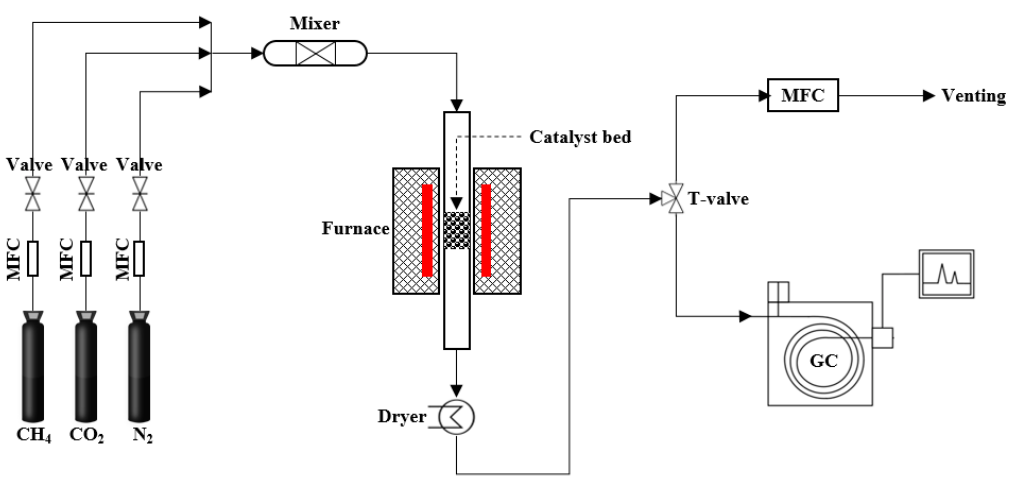
Figure 1. The methane dry reforming reaction and analysis system.